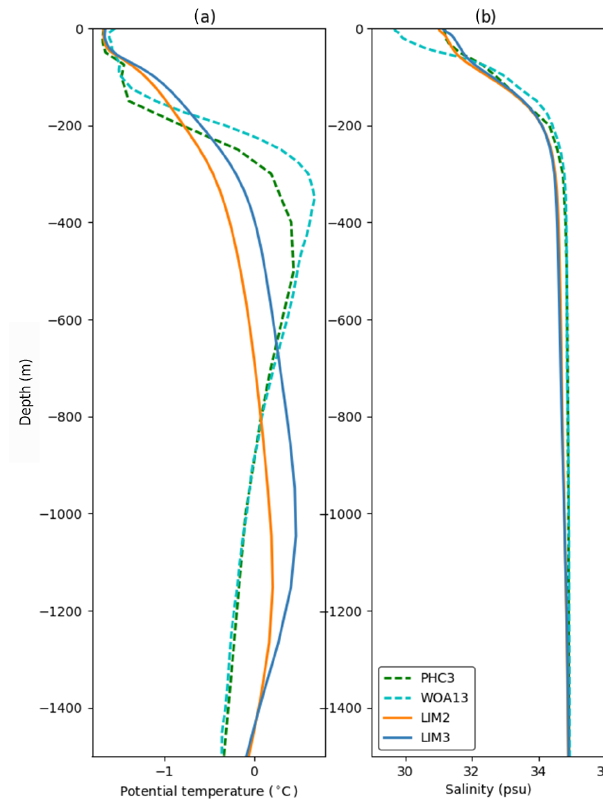
Figure 8. Vertical profiles of (a) potential temperature ( ◦ C) and (b) salinity (psu) at a grid point close to the North Pole (85.5 ◦ N, 140 ◦ W). Green dashed lines are based on the PHC3 climatology by Steele et al. (2001), cyan dashed lines are based on the WOA13 2005–2012 climatology by Boyer et al. (2013), orange lines show values from the NEMO-LIM2 simulation and blue lines from the NEMO-LIM3 simulation. NEMO-LIM profiles are averages over the years 2003–2012. Note that the PHC3 data were used to ini- tialise two NEMO-LIM simulations, after which they largely lost their initially warm Atlantic Intermediate